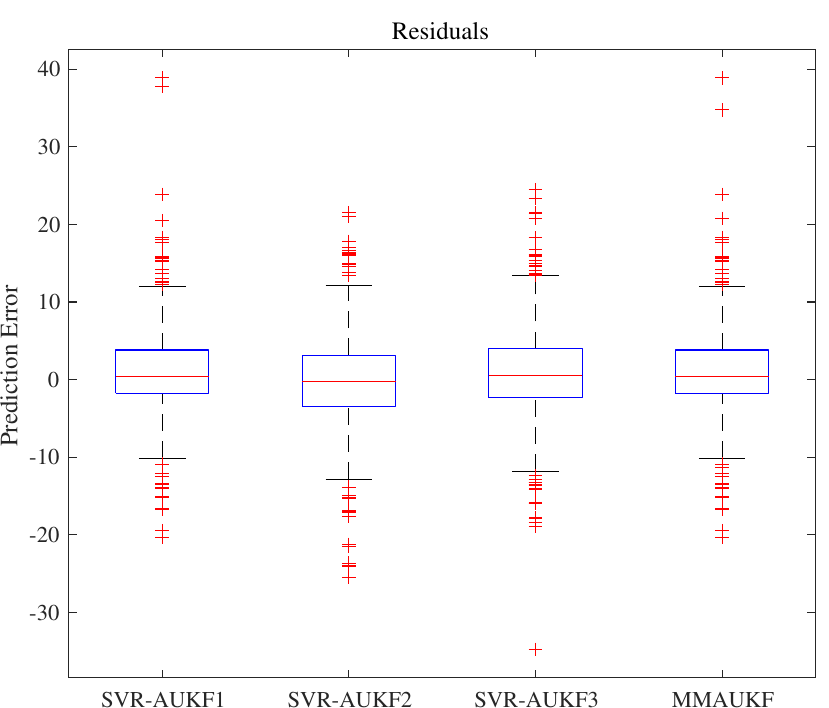
Figure 14. Boxplot of SVR-AUKF1, SVR-AUKF2, SVR-AUKF3 and MMAUKF prediction residual.